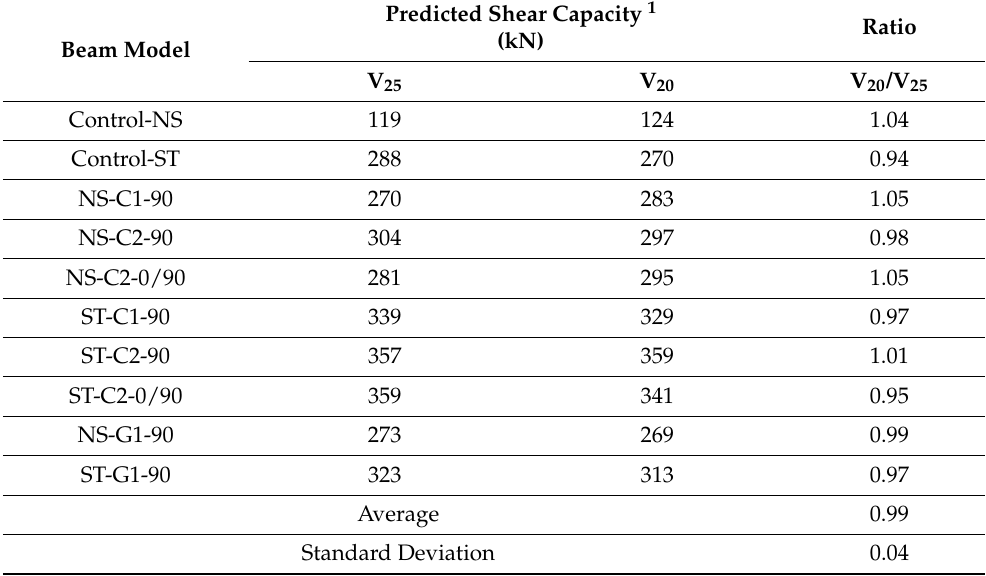
Table 10. Results of the mesh sensitivity analysis.